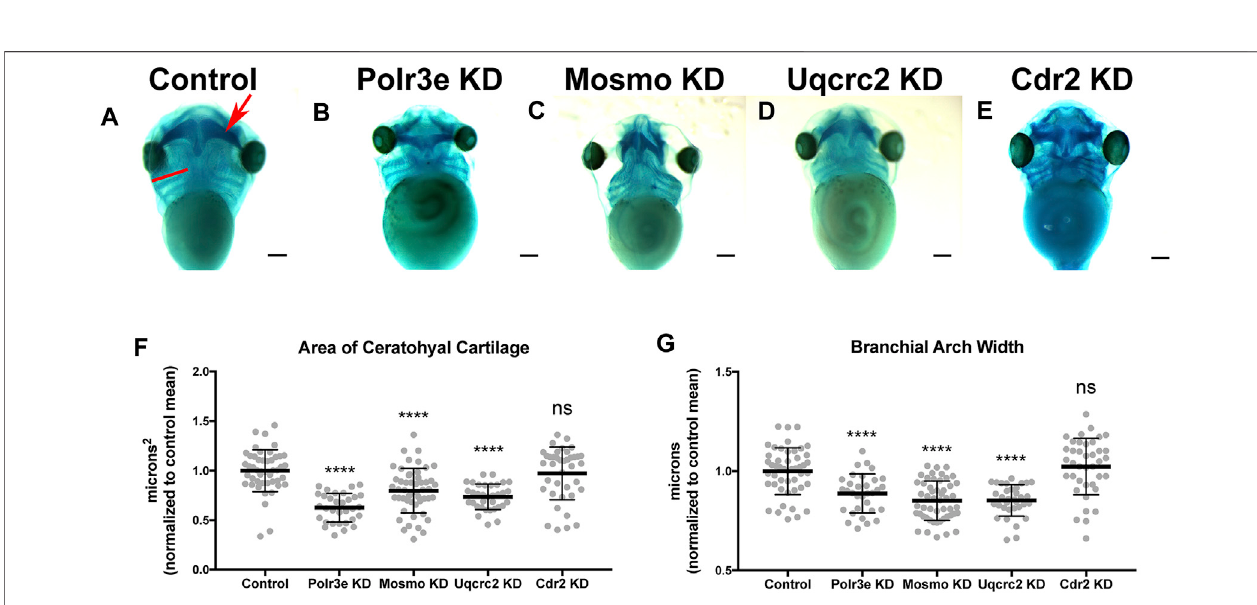
Frontiers in Genetics |